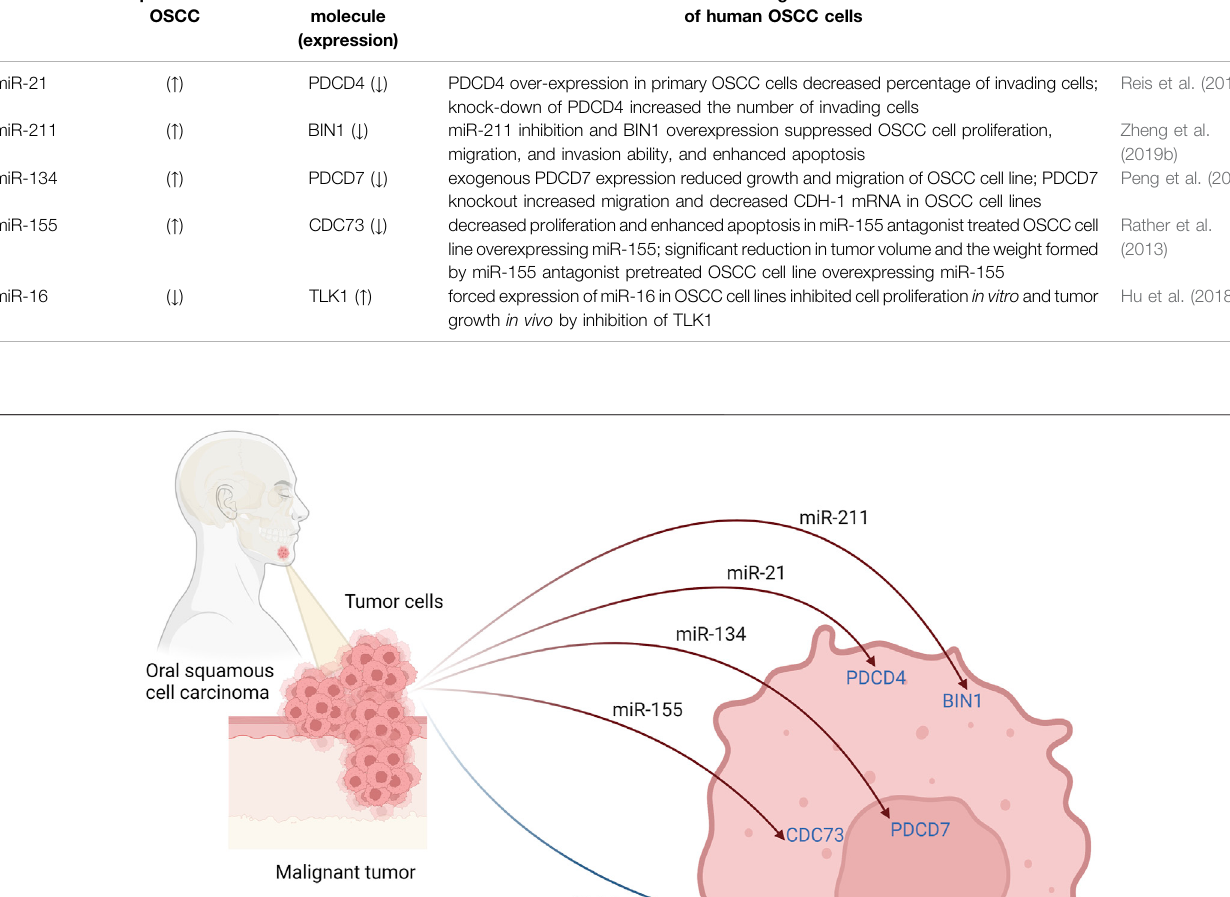
TABLE 4 | Short non-coding RNAs associated with malignant behavior in OSCC. miRNA